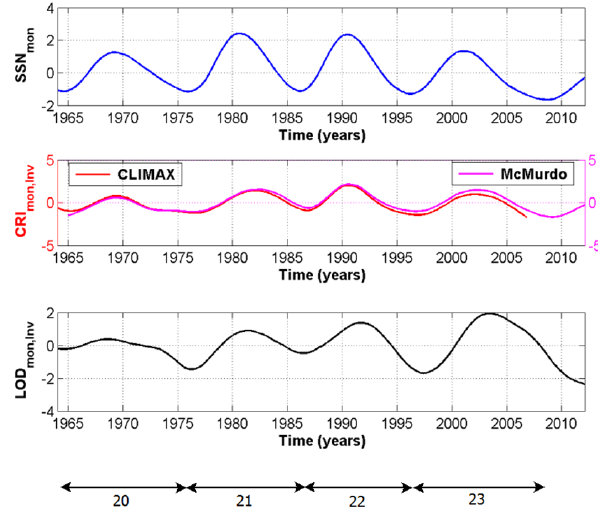
Figure 4. Normalized curves of smoothed (Fig. 3) and linearly de- trended data of SSN, CRI Inv (CLIMAX (red lines) and McMurdo (magenta lines)) and LOD Inv . The curves for the common time in- terval are presented. Solar cycles (from 20 to 23) are indicated at the bottom of the